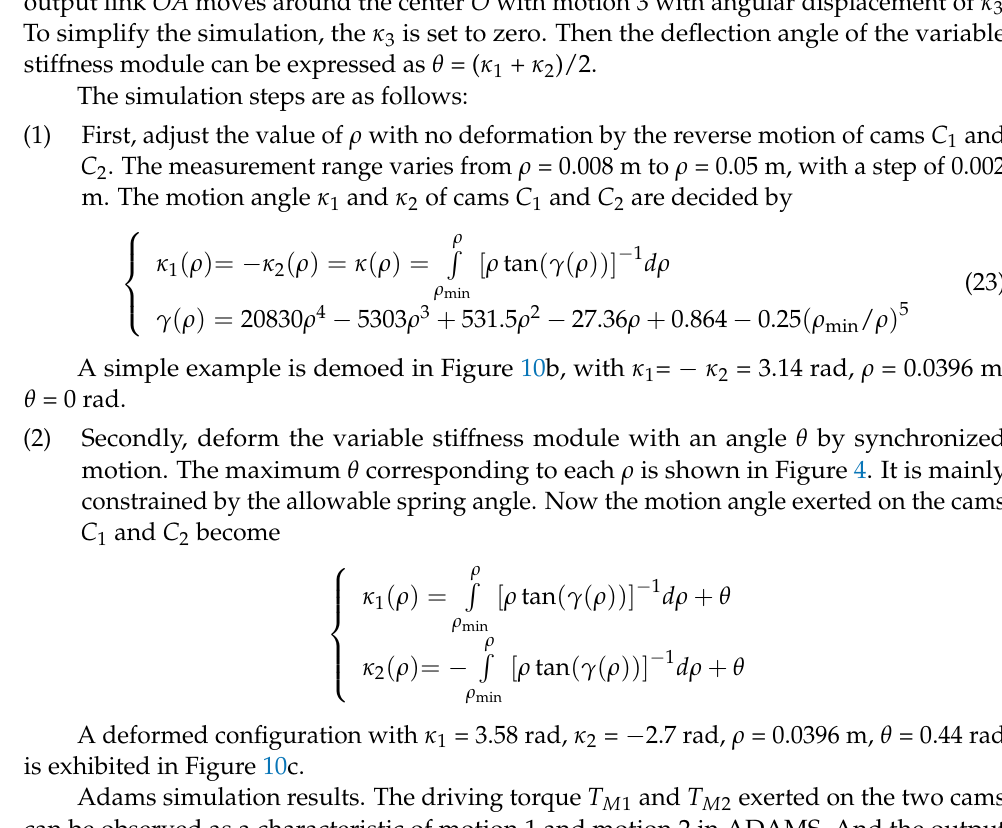
the front view. The cam followers are connected to the linkage mechanism via a